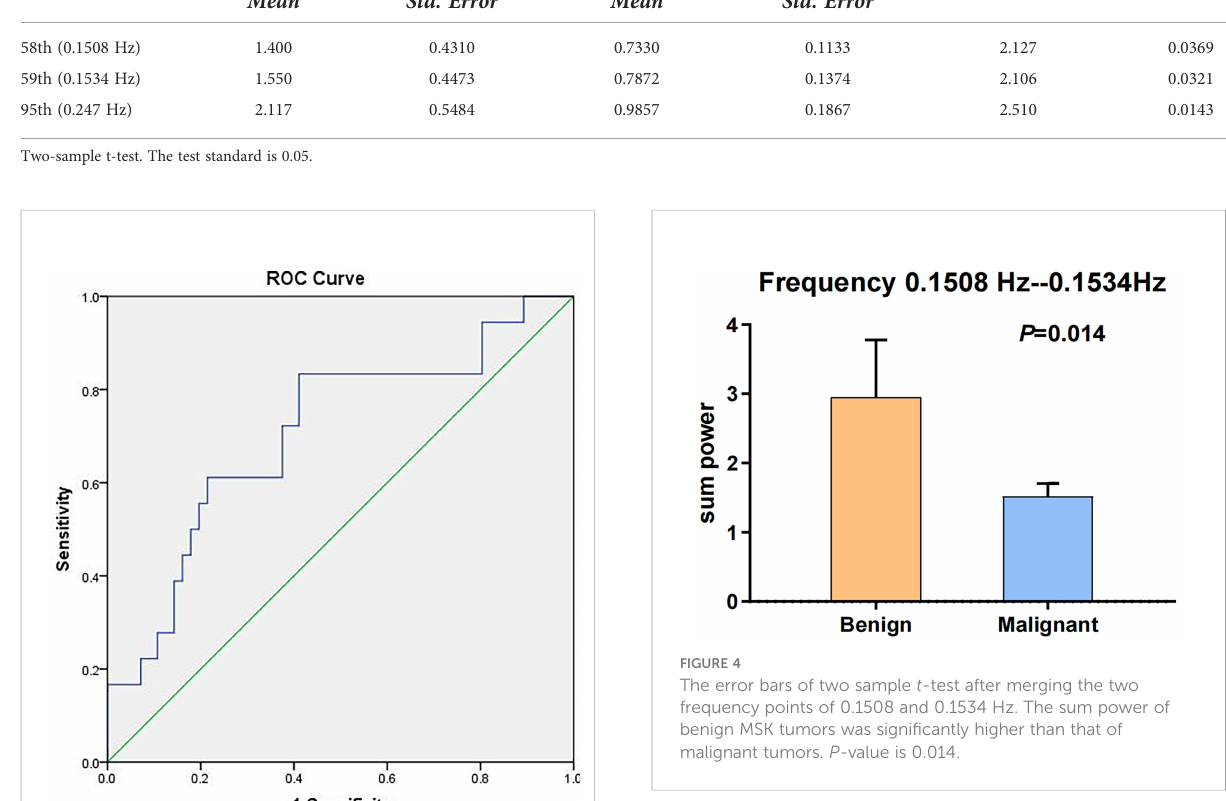
FIGURE 3 The receiver operating characteristic (ROC) curve of mean power of three frequency points (0.1508, 0.1534, and 0.247 Hz). The area under the ROC curve value was 0.706 (P = 0.009). The mean power of musculoskeletal tumor is 0.73130, which means that, if the power value is greater than or equal to 0.73130, then it is considered benign MSK tumor with sensitivity of 83% and speci fi city of 59%.